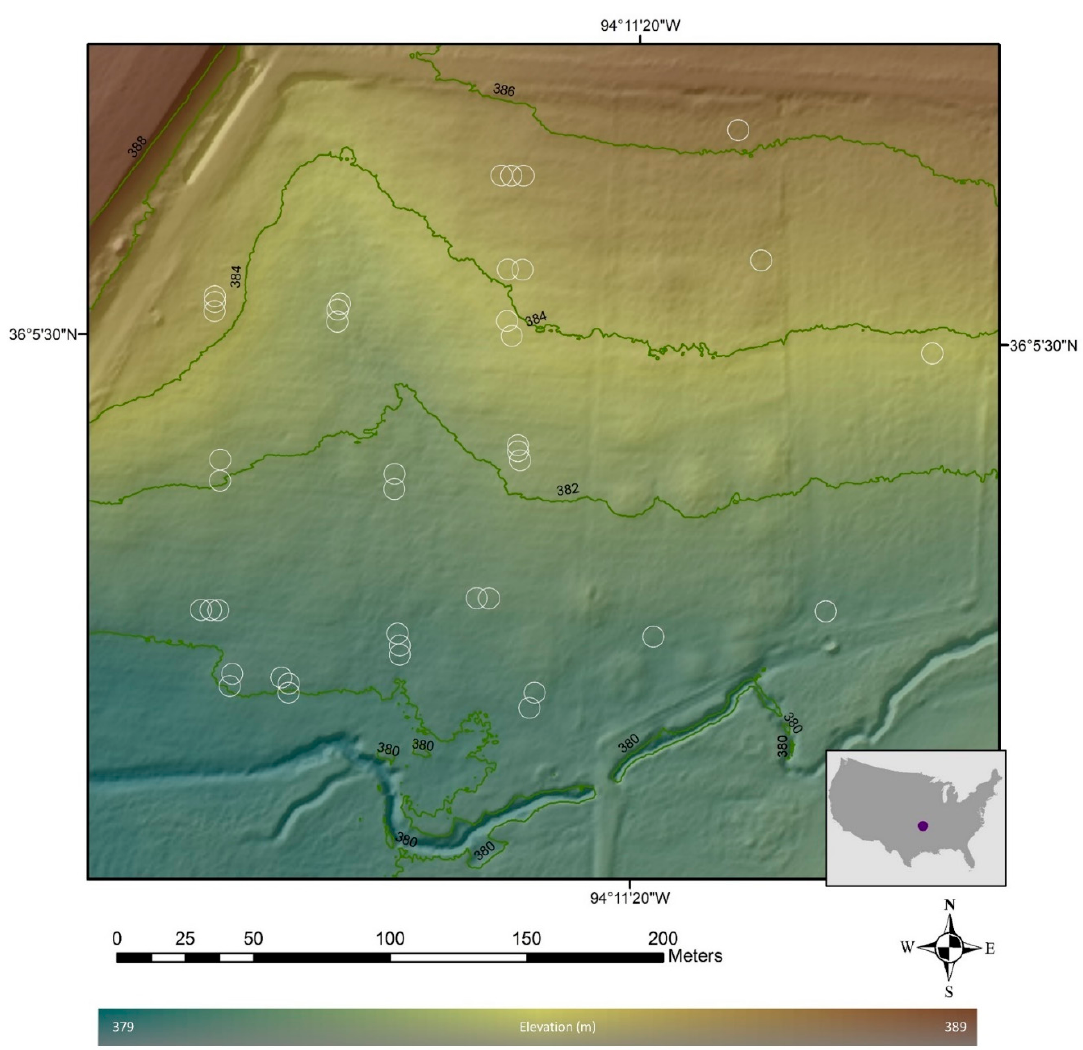
Figure 1. Site of modelling and volumetric water content measurements. The white circles indi- cate the locations of the soil moisture sensors. The green lines indicate elevation contours at the specified elevations in meters. Elevation is color-coded with blues indicating lower values and reds higher